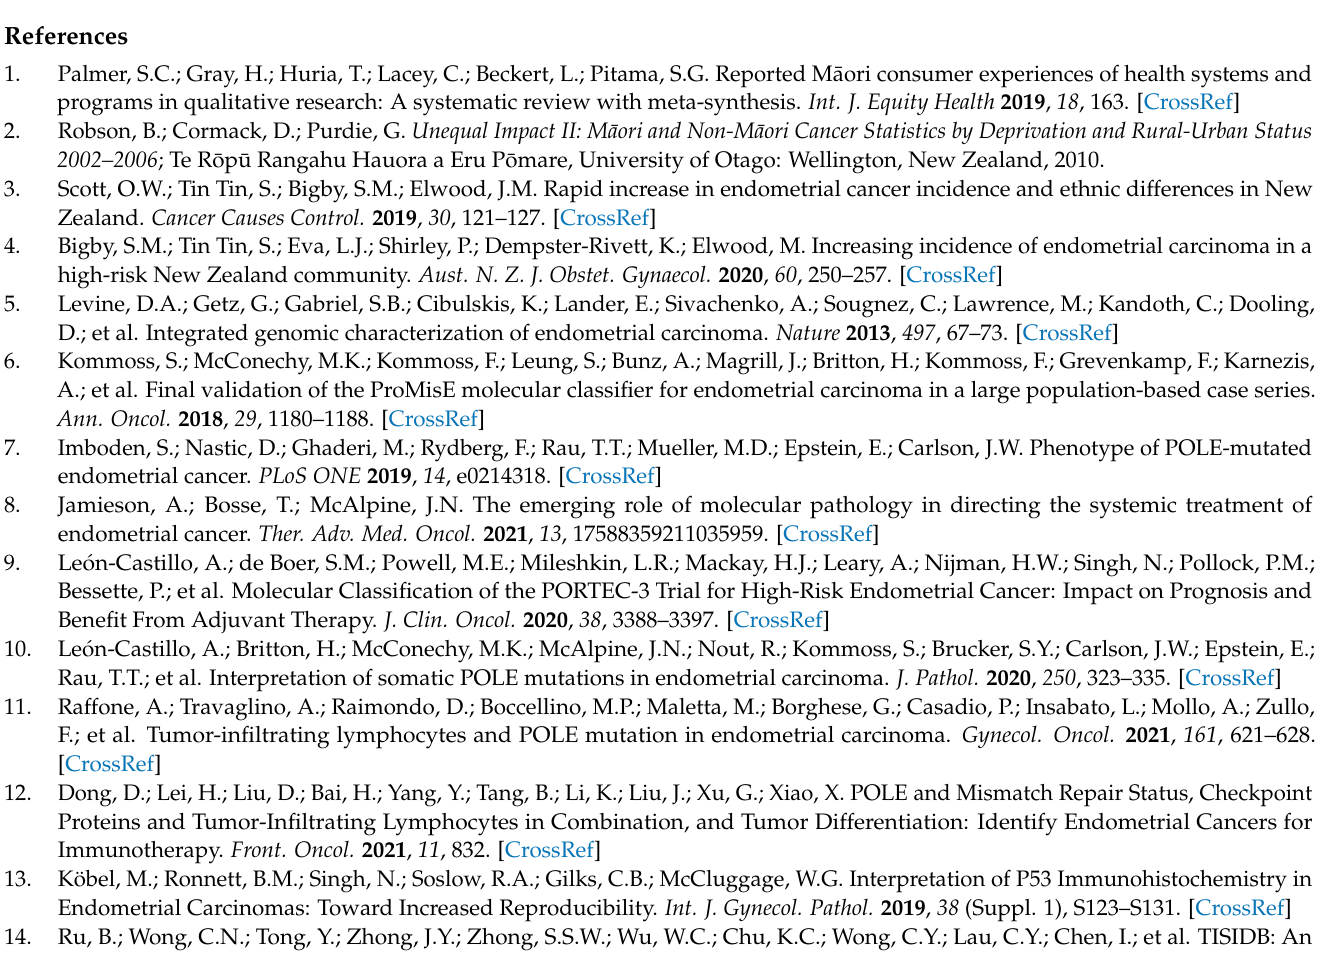
trial tissue. Figure S2: Cbioportal output; Kaplan meier survival of altered immune genes identified in Figure 5; LAG3, TIGIT, CXCL13 and CXCL9. Table S1: IHC conditions. Table S2: CTNNB1 mutations. Table S3: Women who had recurrent endometrial cancer during the study